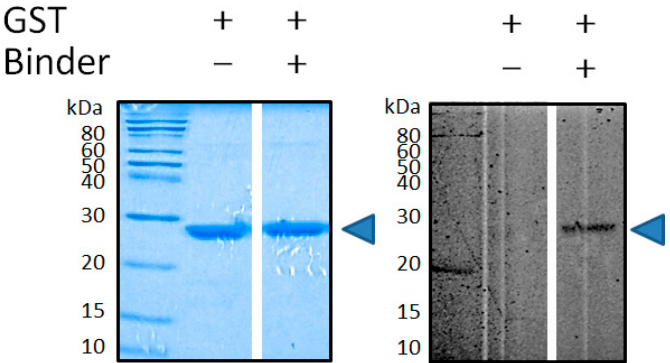
Figure 3. Specific conjugation between glutathione-S-transferase (GST) and the caged binder, confirmed by 15% SDS-PAGE/fluorescence imaging. GST (blue arrow) was visualized by CBB staining (left panel), and the binder-conjugated GST was visualized by fluorescence in the same gel (right panel). For the fluorescence imaging, the excitation wavelength was 405 nm, and a band-pass filter (605 nm) was used for the detection. Plus (+) and minus (-) stand for presence and absence of the suggested molecules (i.e., GST or the binder), respectively.